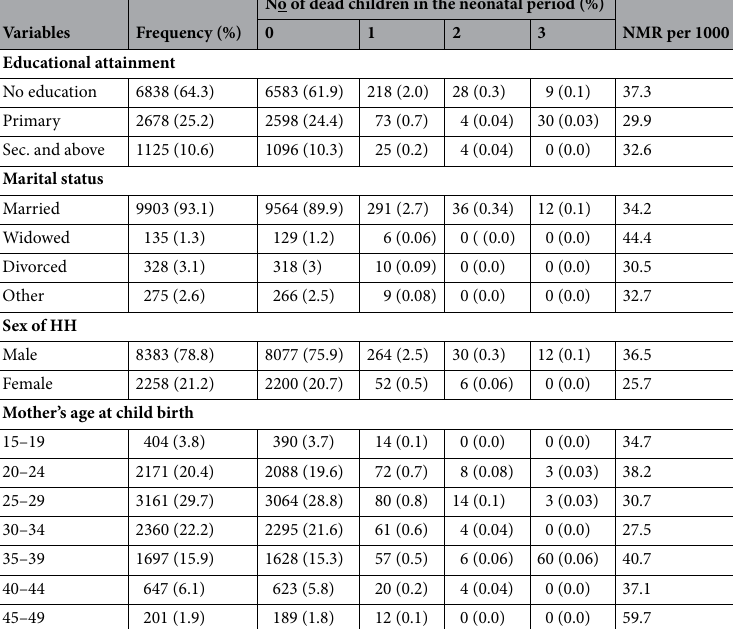
Table 5. Demographic (maternal) factors.